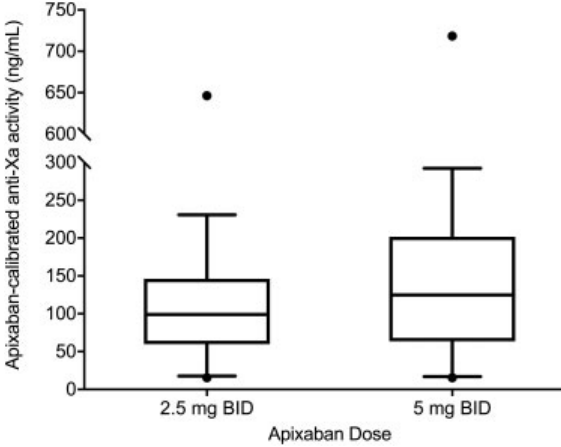
Fig. 1 Apixaban-calibrated anti-Xa activity by dose. Blood samples were drawn immediately prior to the morning dose of apixaban. Boxes represent median and interquartile range, whiskers represent 10th to 90th centiles, and points represent minimum and